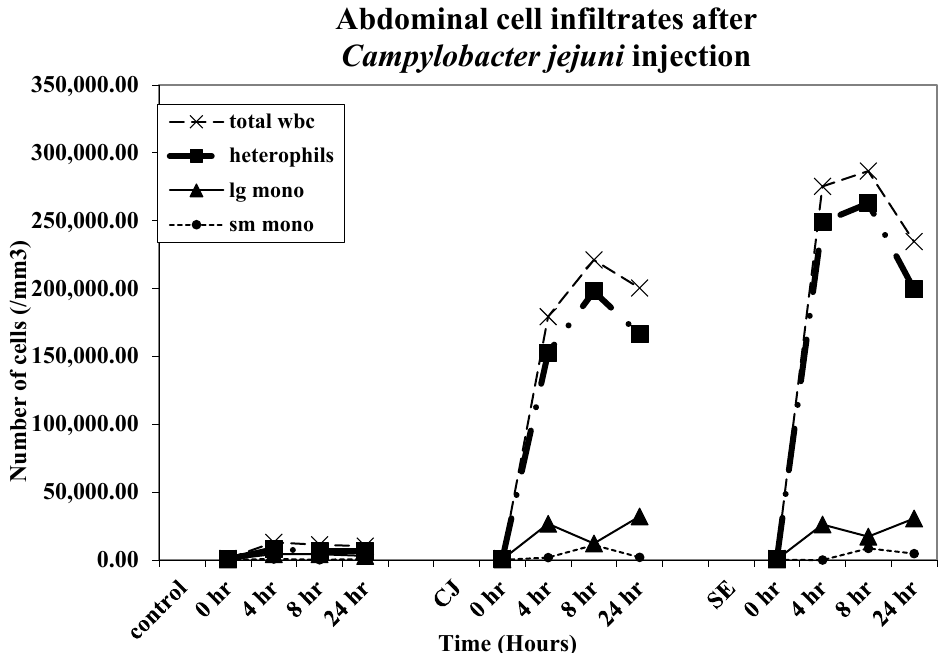
Figure 2. Abdominal cell infiltrates . Chicks were injected IA with Campylobacter jejuni [(CJ)1 × 10 8 colony-forming units (CFUs)]. SE groups received 5 × 10 3 CFU/ bird. Abdominal cell infiltrates were monitored (five chicks/group/timepoint) at 0, 2, 4, 8, and 24 h post-injection. The recovered IA cellular infiltrates were counted on a hemocytometer as described above. A cytospin smear was prepared for each chick at each time point and stained, and fixed and differential leukocyte counts were performed for each chick IA exudate sample as described earlier. Peripheral blood and IA cell infiltrate studies represent three repetitions (15 birds per group/time point/repetition).